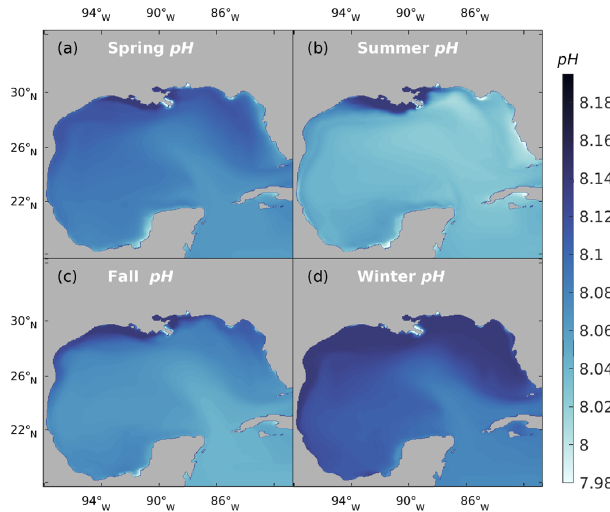
Figure 9. Seasonally averaged sea surface pH over